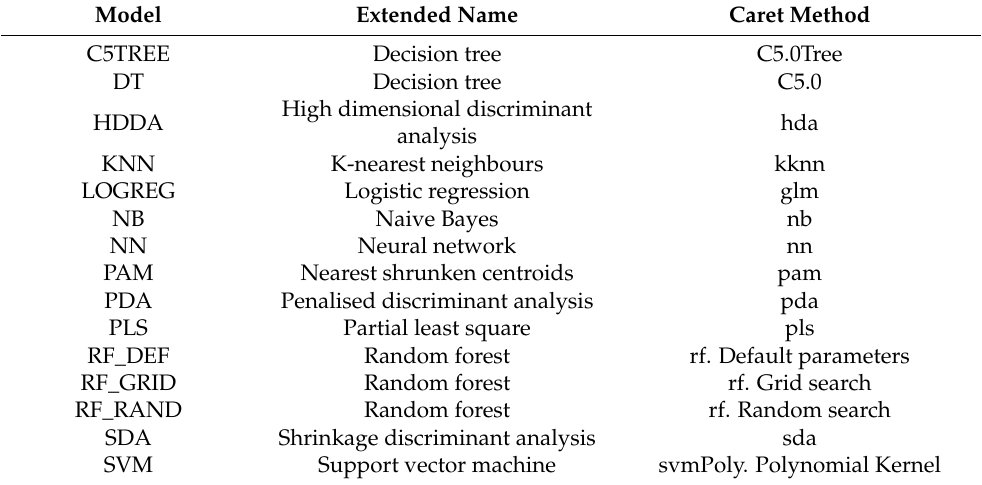
Table 3. Models’ legend, extended name and method used to calculate the classifier using the caret package of the R statistical